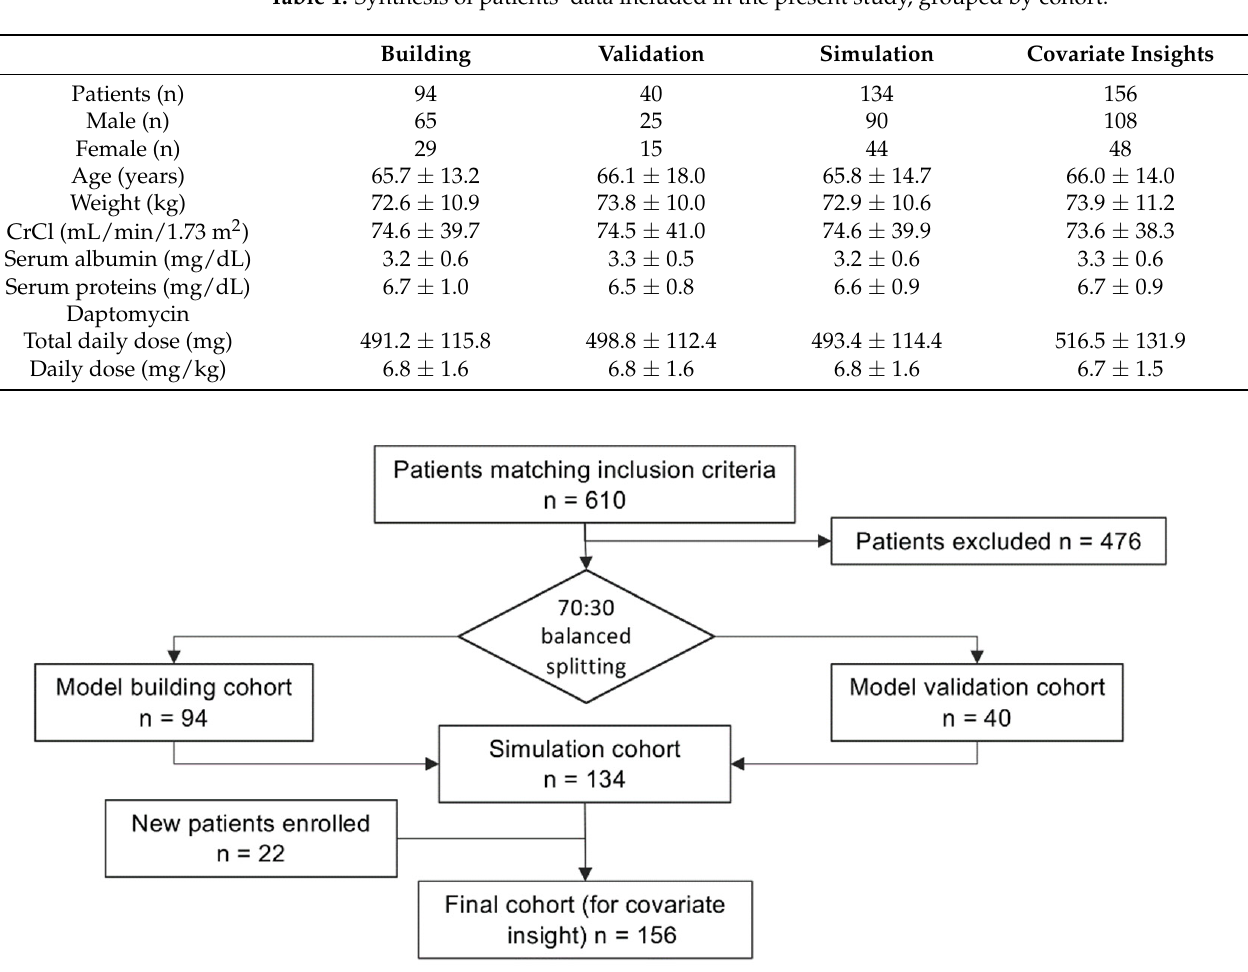
Figure 1. Flow diagram showing the patient inclusion process of the present study. Measured daptomycin concentrations are reported in Table 2. At a first look, the